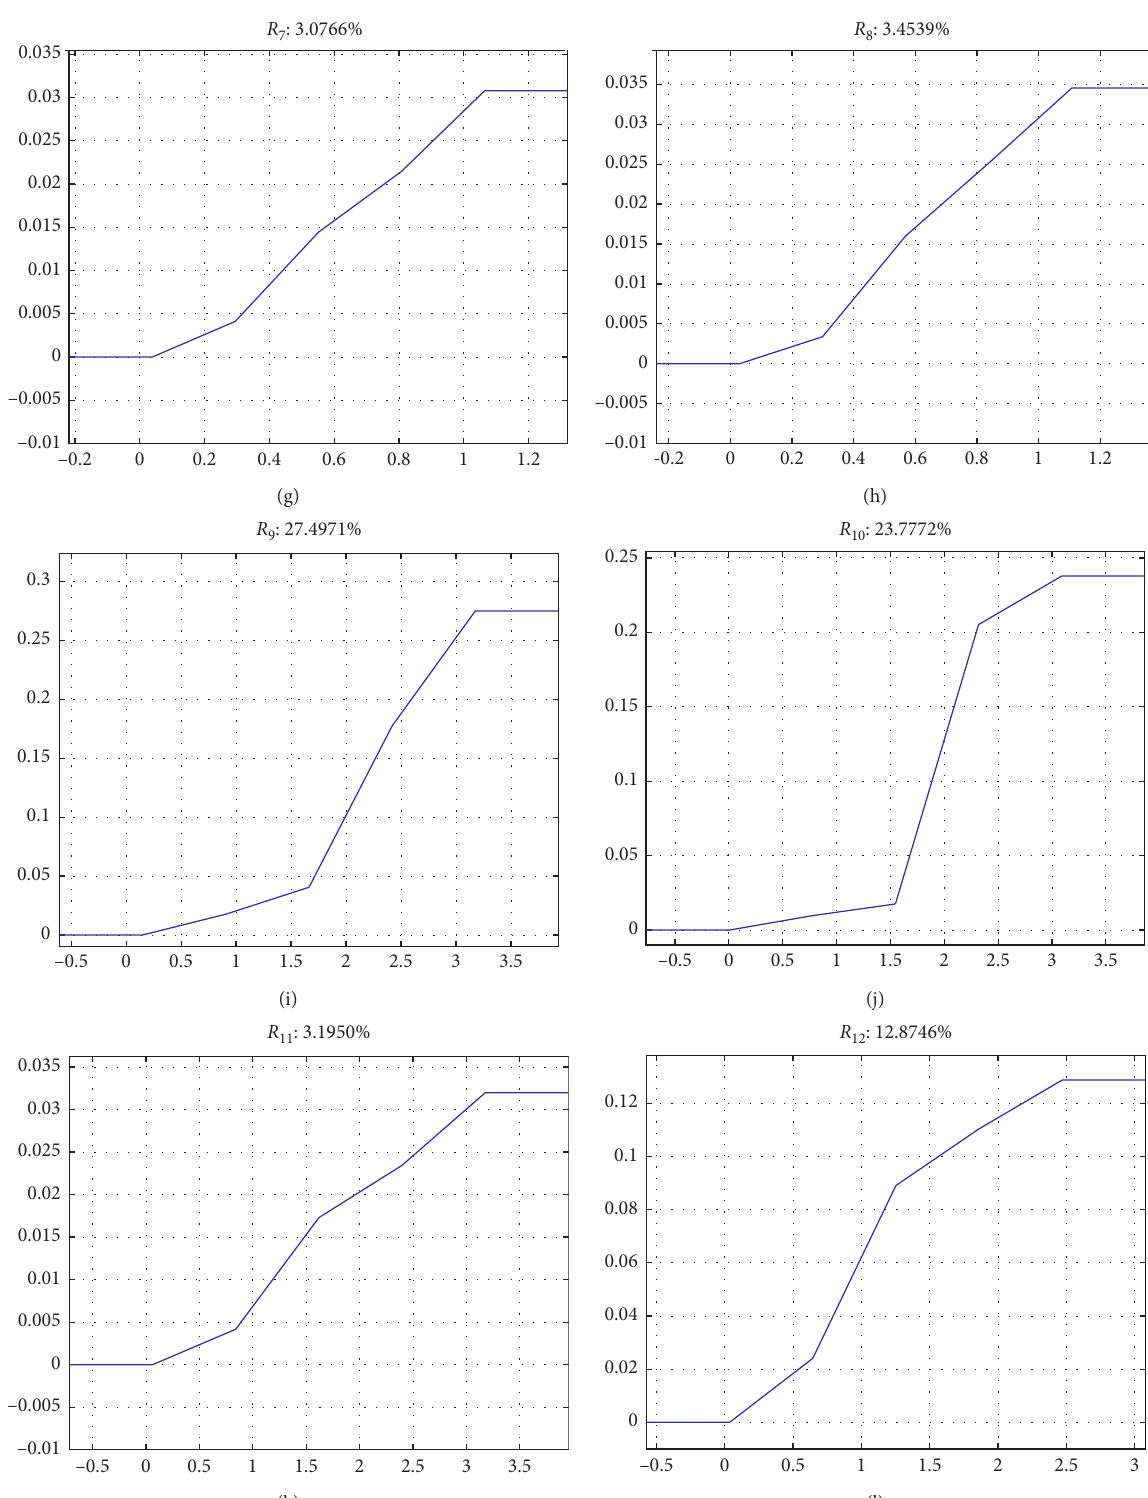
Figure 2: Marginal utility of each financial ratio with the SM-UTADIS method (training